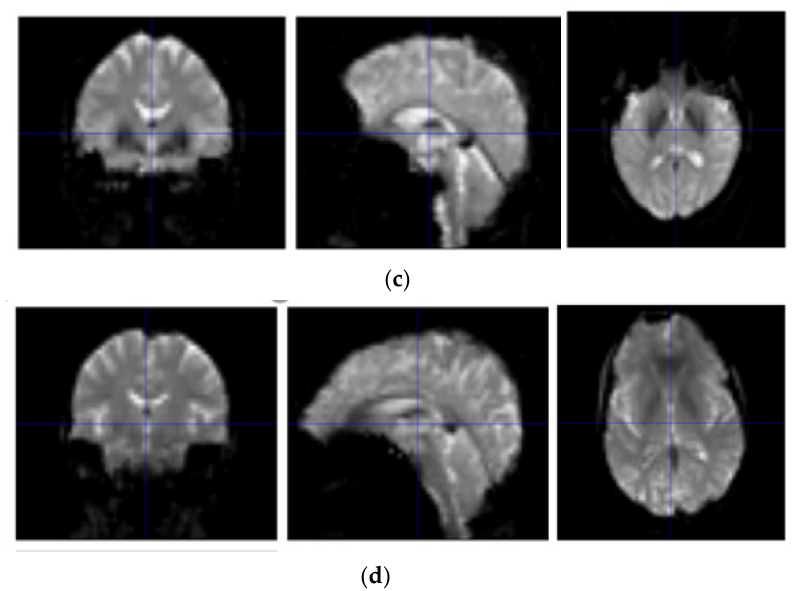
Figure 1. Resting-state fMRI image display of NC, AD, sMCI, and pMCI subjects. ( a ) Resting-state fMRI image display of a NC subject; ( b ) resting-state fMRI image display of an AD subject; ( c ) resting-state fMRI image display of a sMCI subject; and ( d ) resting-state fMRI image display of a pMCI subject.